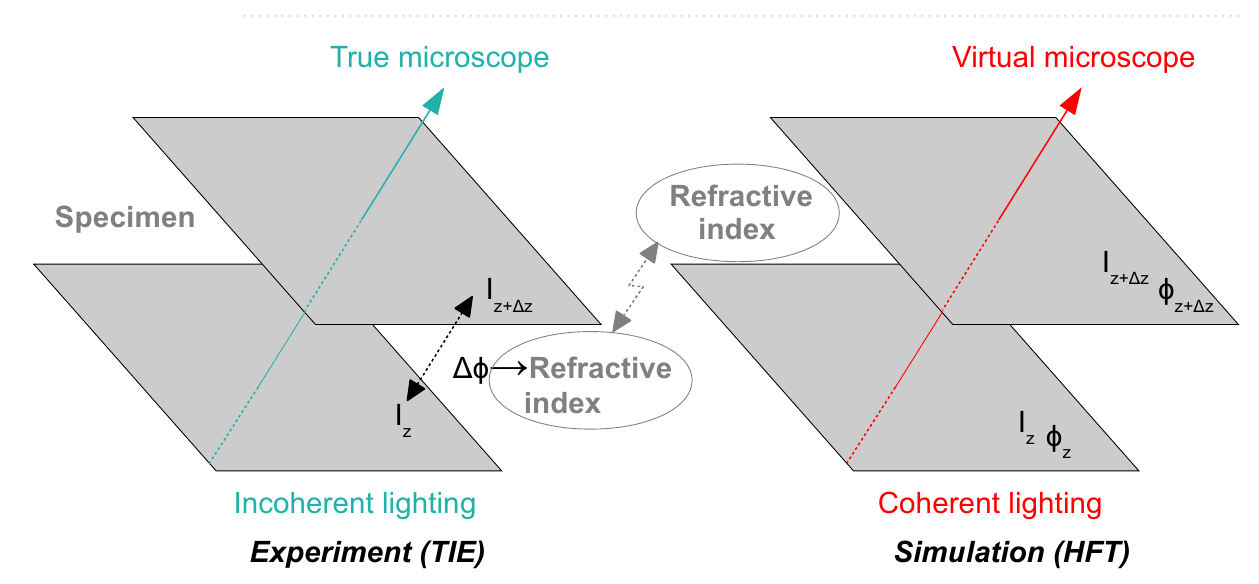
Figure 5. Left: experiment with a microscope using incoherent lighting. Right: image simulation using coherent